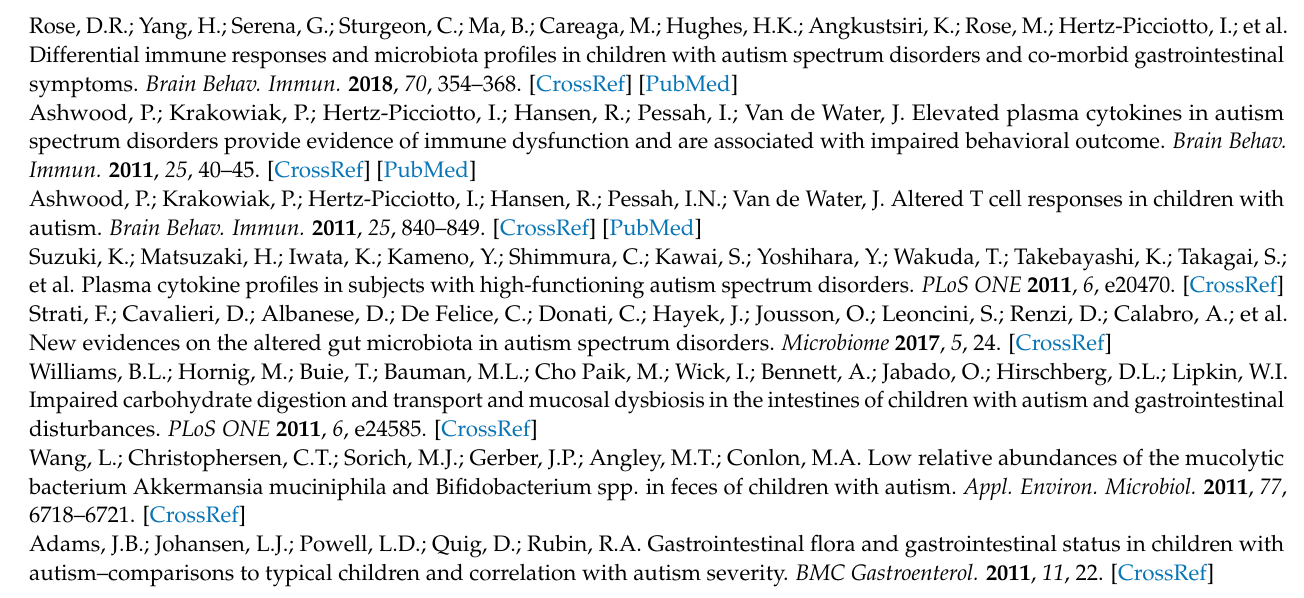
diversity; Figure S2: Prenatal ABX administration alters offspring gut microbiota taxonomy; Figure S3: Taxonomy representation at genus and species level; Figure S4: Inducible cytokines are affected by ABX exposure; Figure S5: PICRUSt predictions of metabolic pathways; and Table S1: Percentage relative abundances of sequences classified to